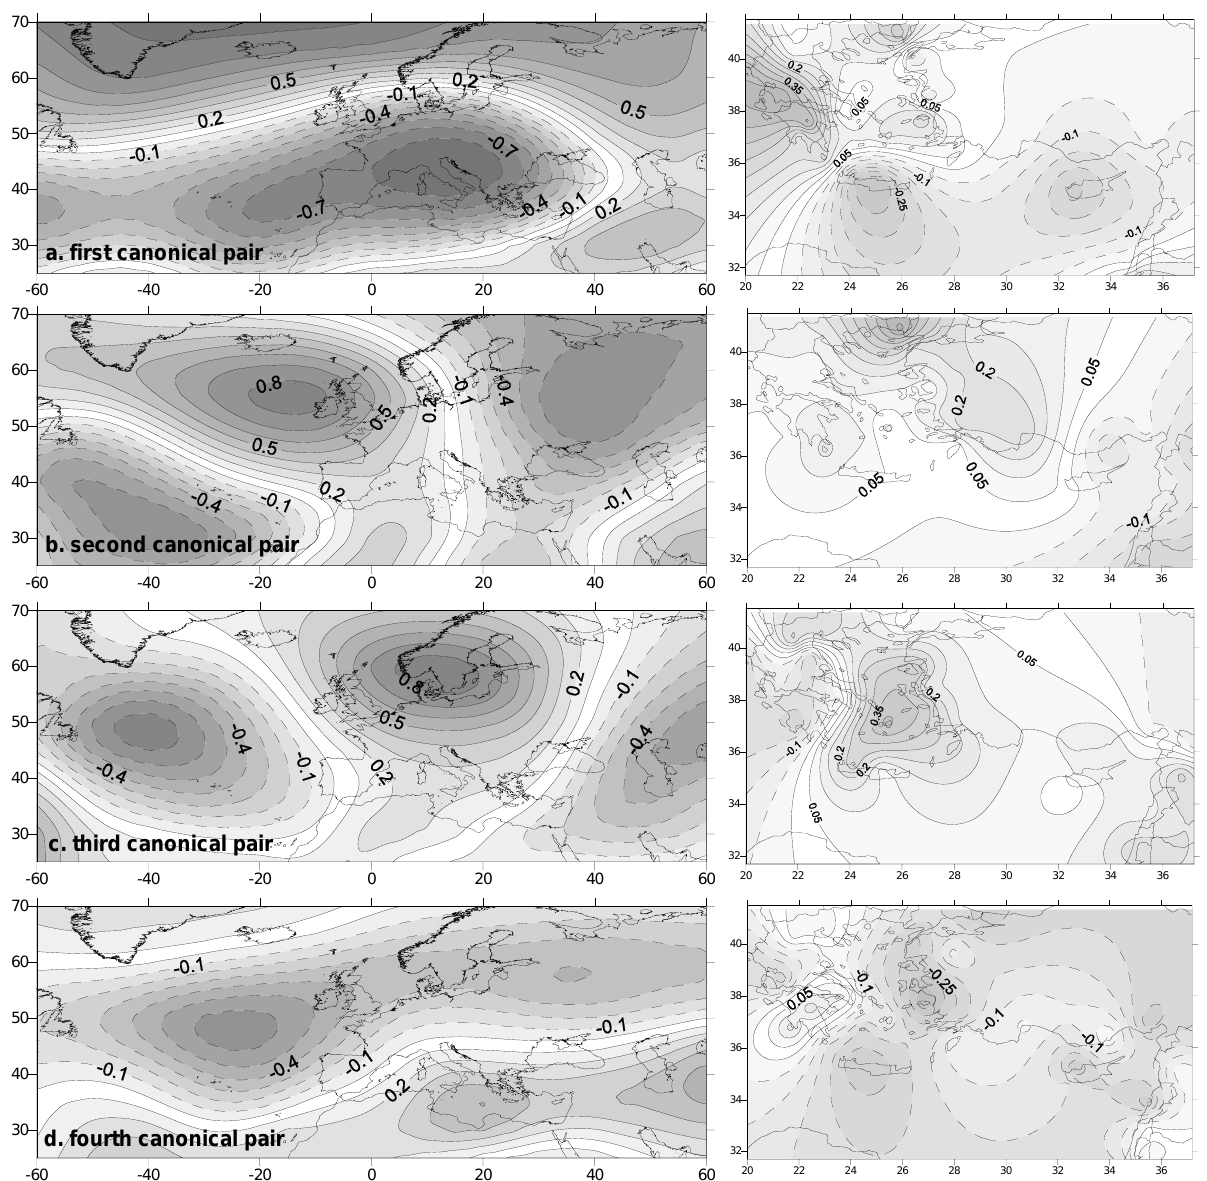
Fig. 1 . Canonical correlation loadings of four RCCA pairs (a, b, c and d, respectively) for the Fig. 1. Canonical correlation loadings of four RCCA pairs – (a) , (b) , (c) and (d) , respectively – for the 500hPa geopotential heights (left 500hPa geopotential heights (left column) and SDII (right column) for the present climate; dashed column) and SDII (right column) for the present climate; dashed contours indicate negative contours indicate negative values.